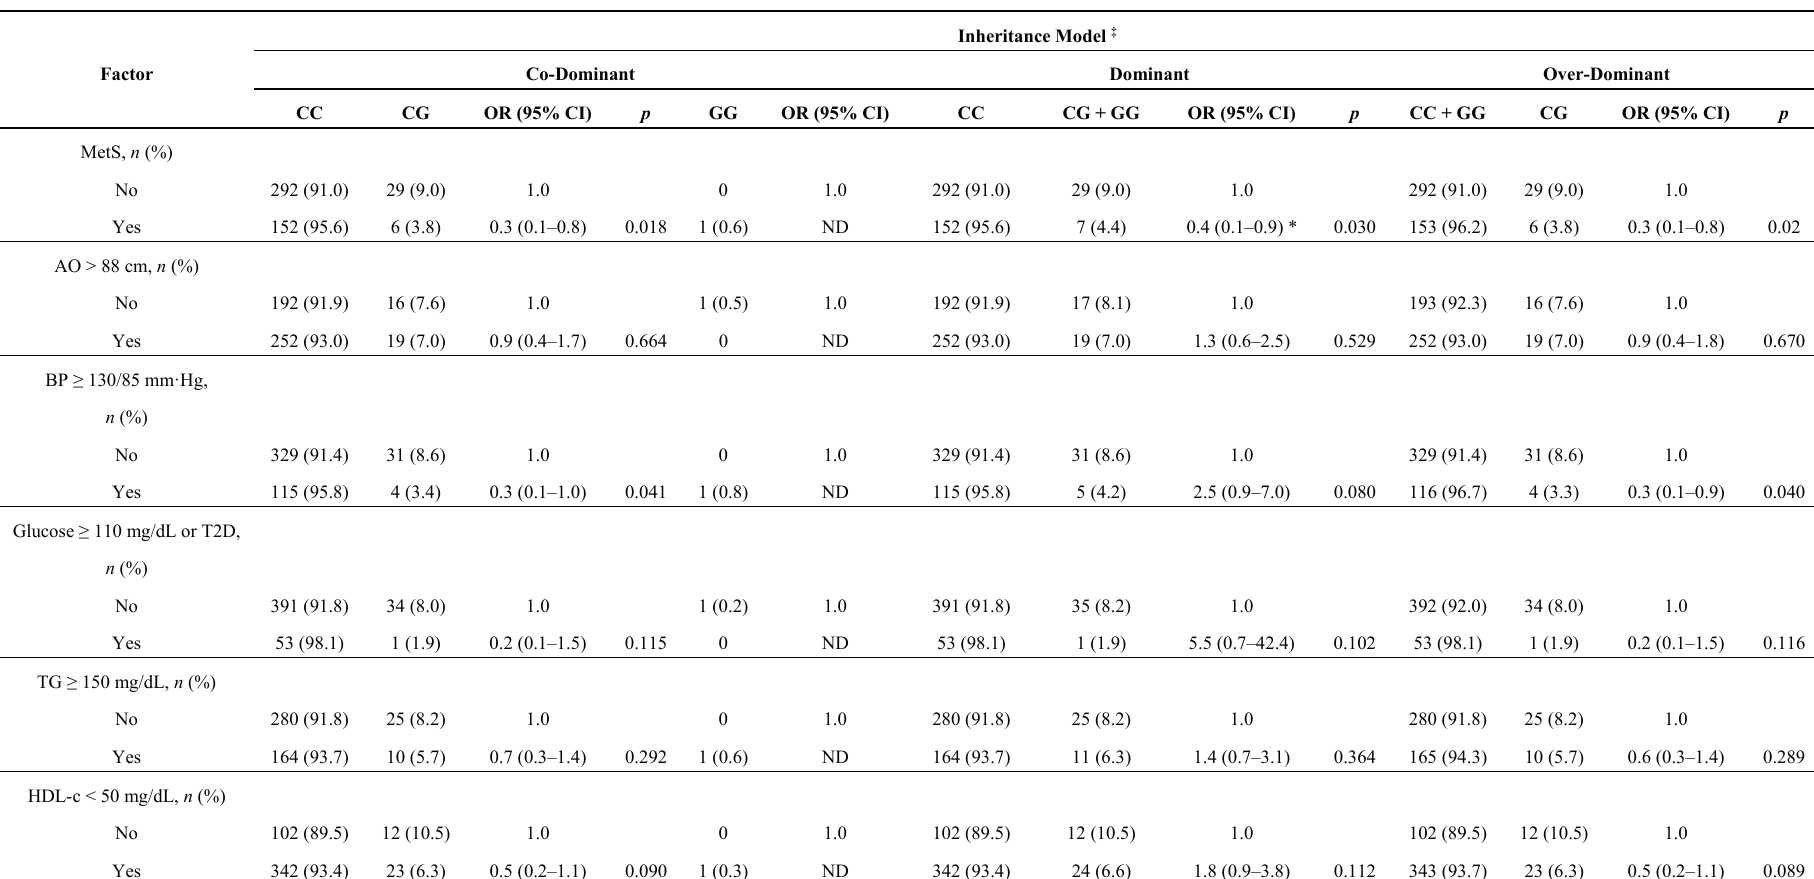
Table 4. Association between SNP rs328 in LPL gene with MetS and their